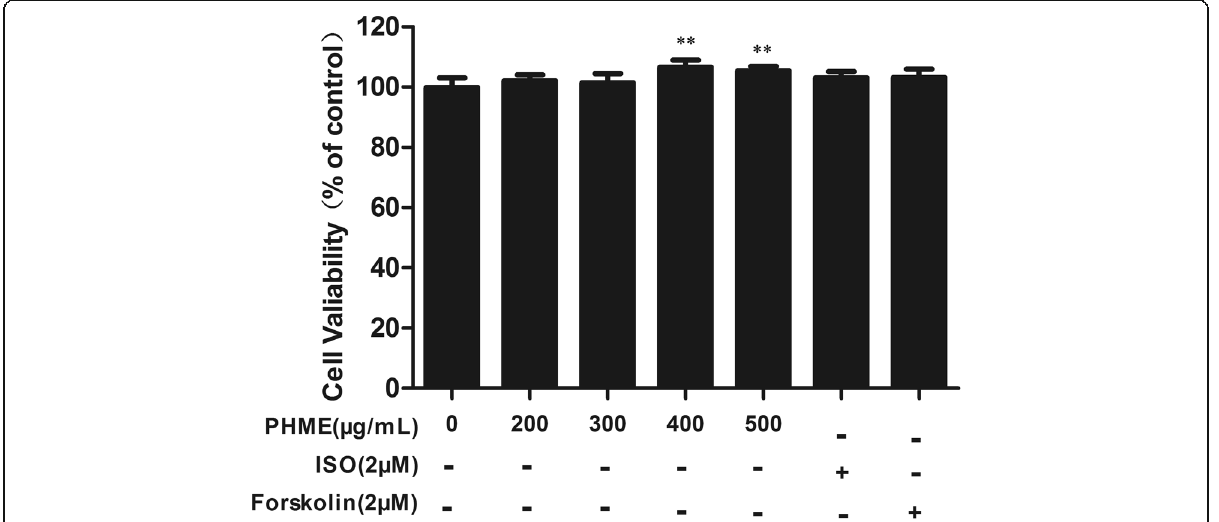
Fig. 1 Effect of PHME on viability of fully differentiated 3T3-L1 adipocytes. The cell viability was analyzed by MTT assay after treatment of PHME (200 – 500 μ g/mL) for 24 h, and cells treated with 0.1% dimethyl sulfoxide were used as control group. Isoproterenol (ISO) and forskolin were used as positive controls. Data represent as means±SD ( n = 6), ** P < 0.01 vs. control